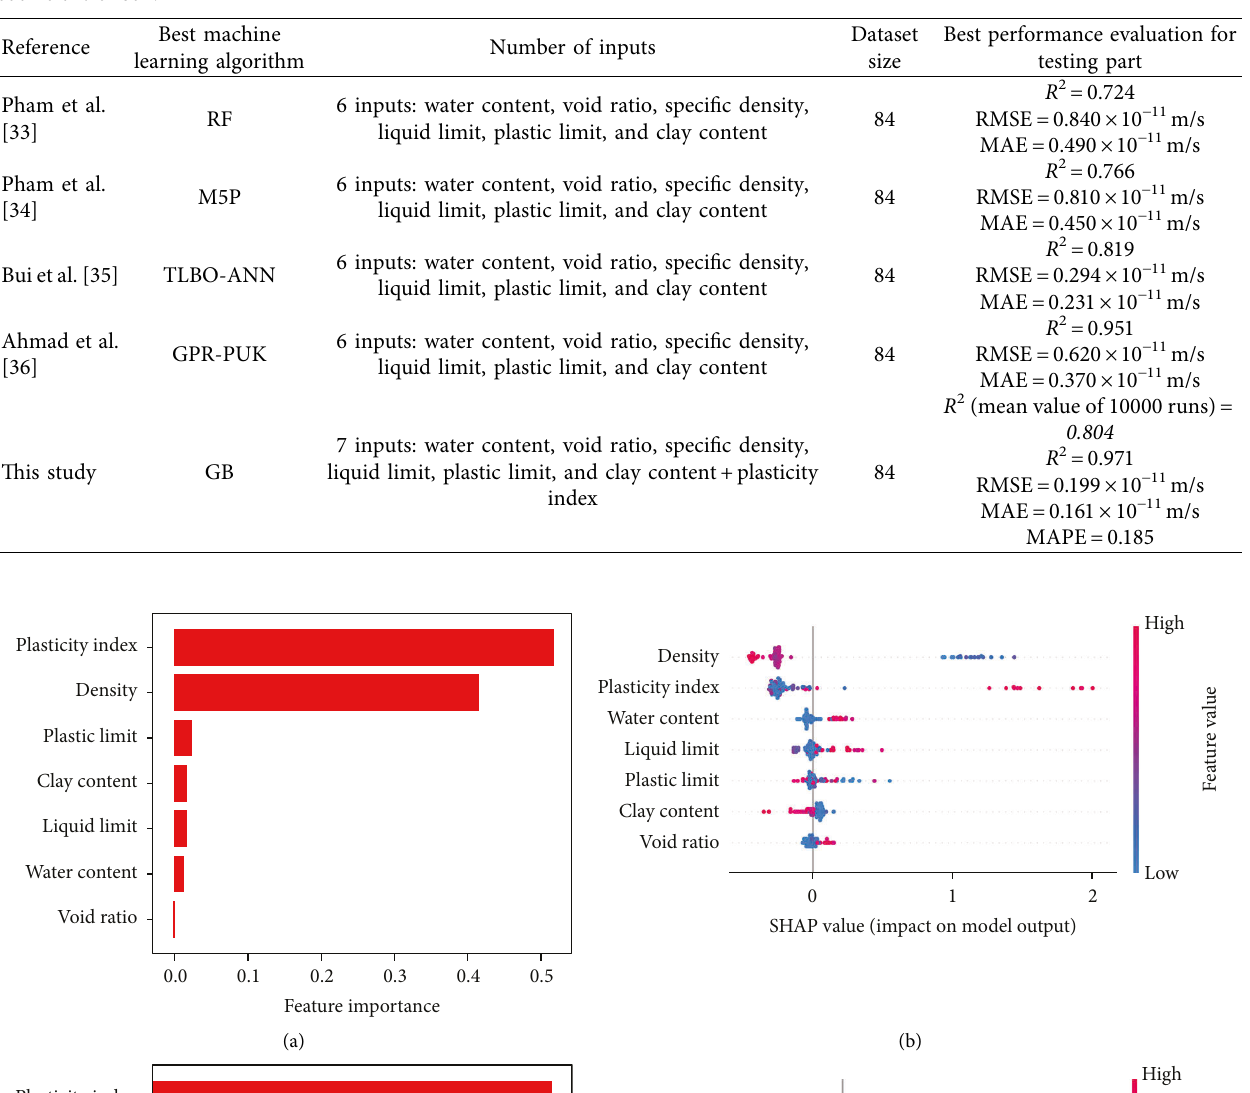
Table 7: Comparison between ML models in previous studies and the GB model proposed in this study for predicting the permeability coefficient of soil.